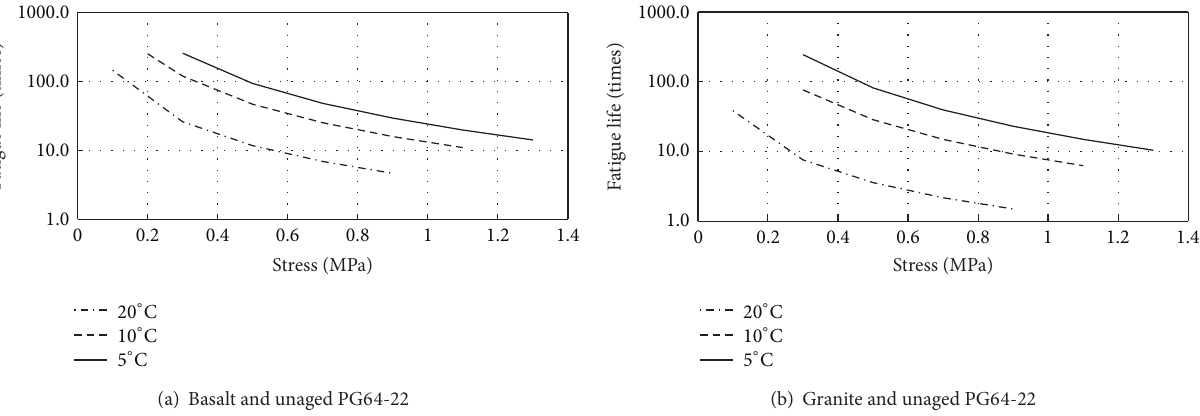
Figure 6: Predicted fatigue lives for aggregate and unaged asphalt (semilog).